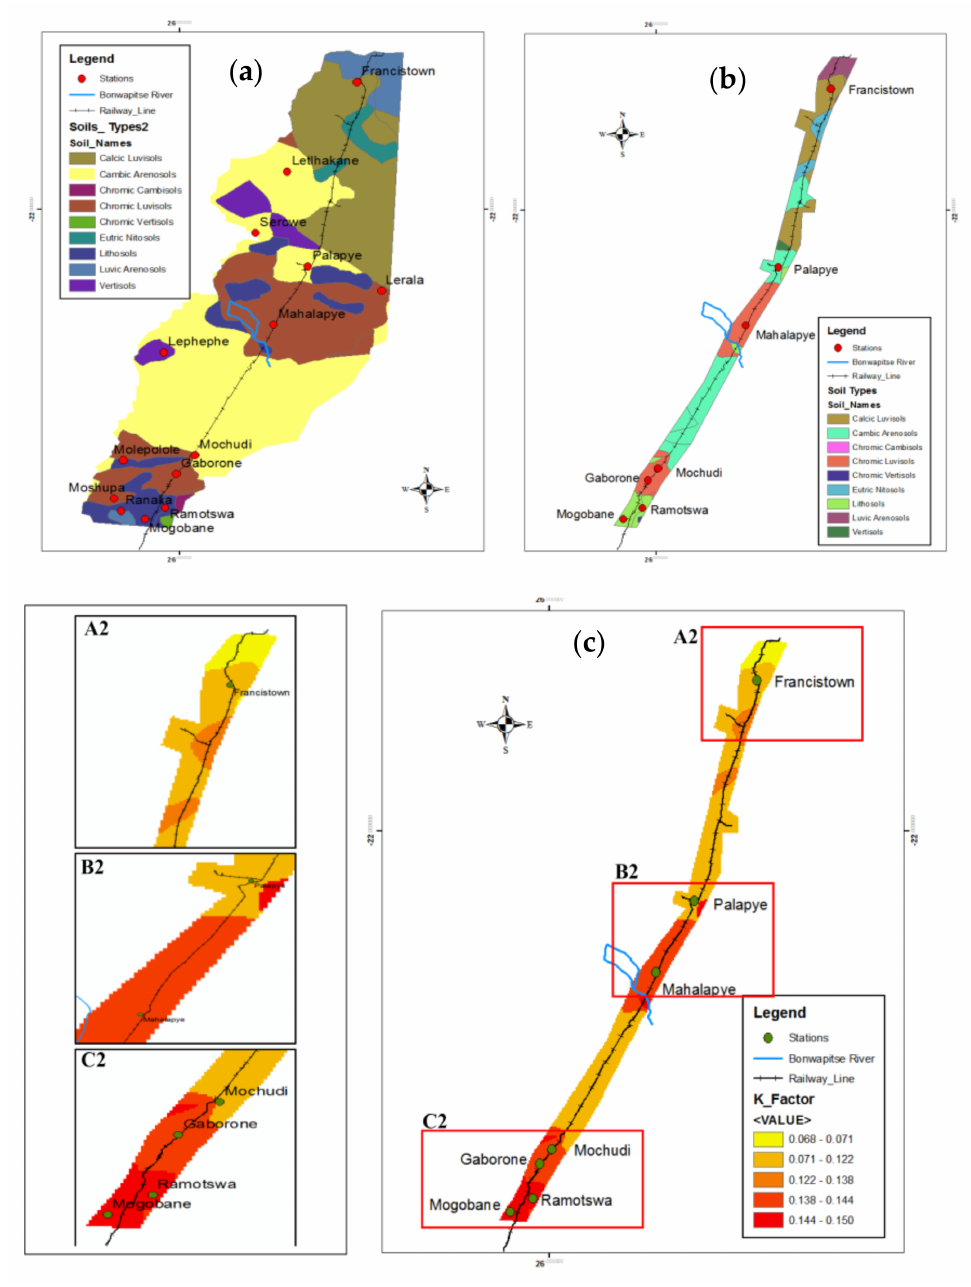
Figure 5. ( a , b ) are soil types within the LRB and the BRC. ( c ) Derived K-factor for the